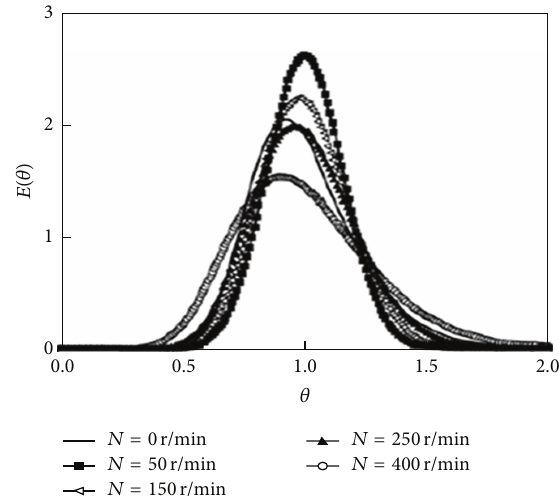
Figure 11: Effects of impeller speed with RTD curves by Cao et al. 2009 [43].